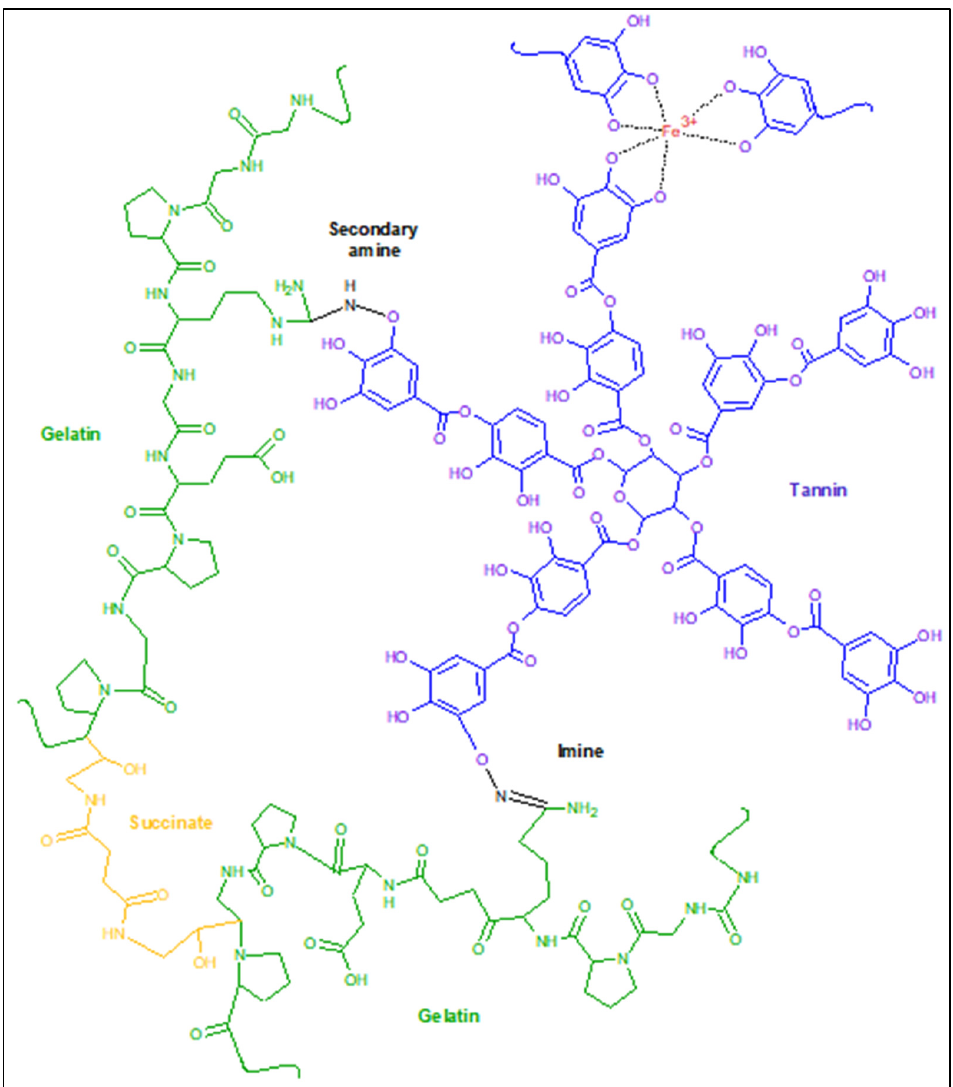
Figure 1. The proposed scheme for the formation of gelatin–tannin hydrogels based on Gelatinol ® . Other medical products of succinated gelatin are also known, such as the blood- substituting solutions Volutenz ® , Gelofusine ® , etc. The main difference consists in the resulting molecular weight distribution, as a result of the use of various types of gelatin, preparation of the monomer, or the synthesis process of the gelatin-succinated solution [12]. In addition, the concentration of gelatin in the above solutions is about 4% mass.